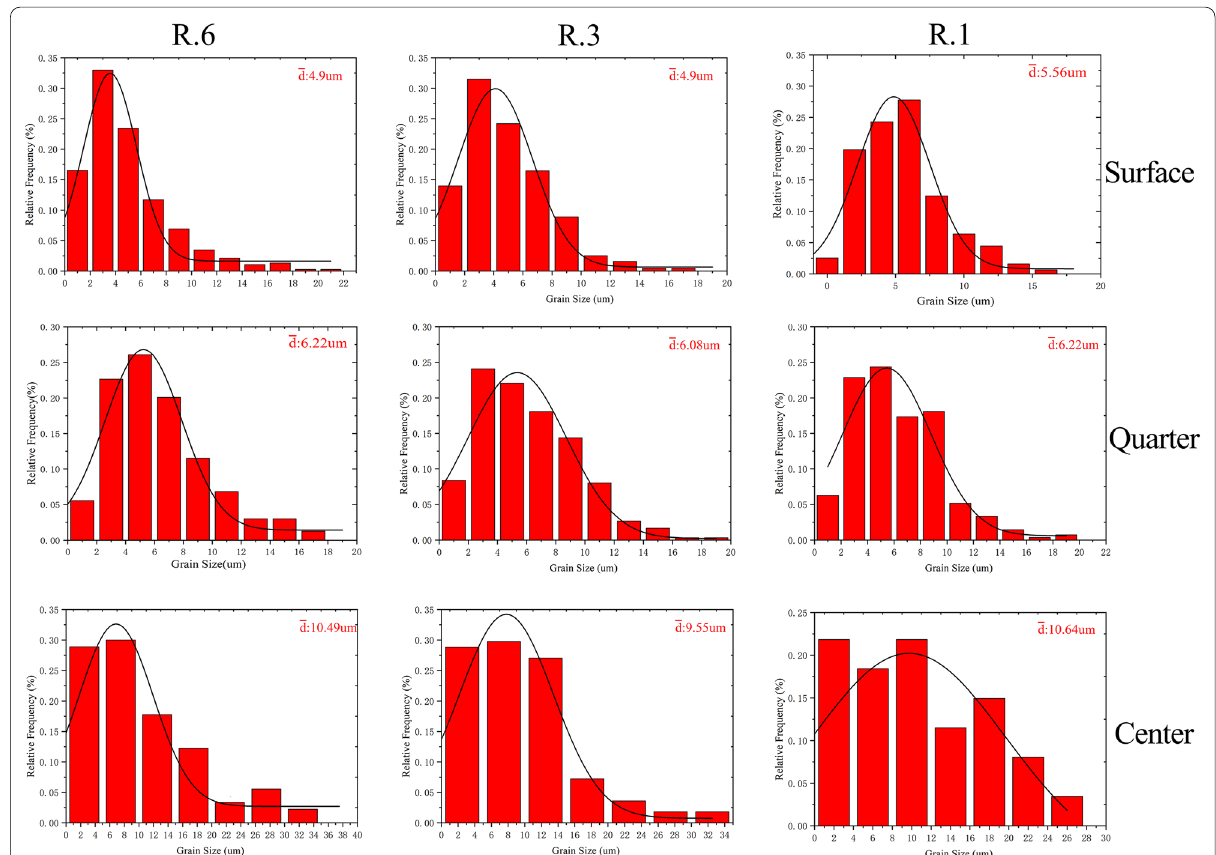
Figure 5 Grain size distribution of different regions along the transverse and thickness directions